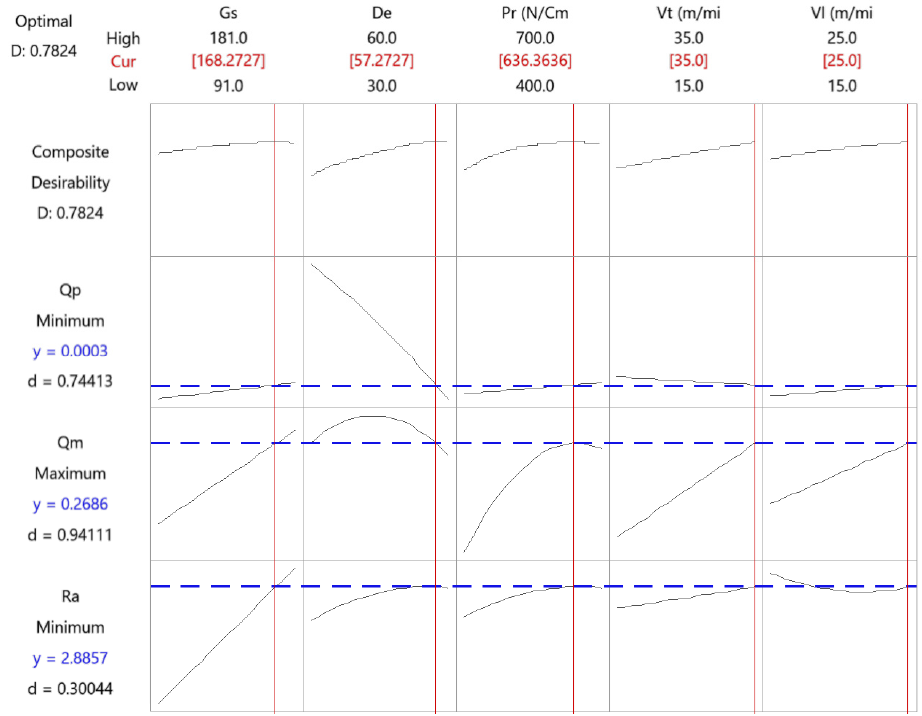
Figure 10. Multi-objective optimization of the rough honing operation.